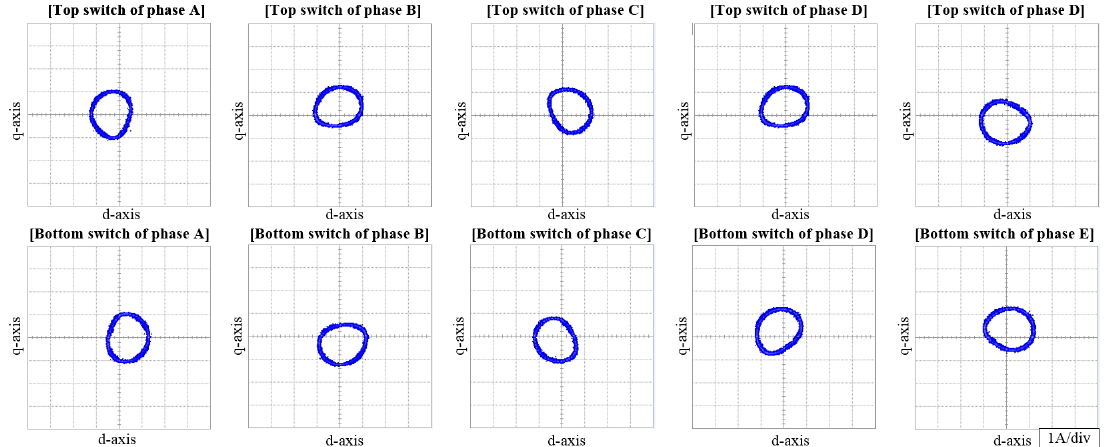
Figure 3. Trajectory of stationary d 1 ‐ q 1 axis current for open fault of each switch at 300 rpm and 1 A.